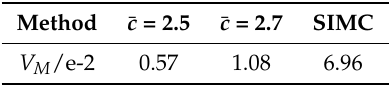
Table 7. Example 3. The table shows the comparison of the settings for Algorithm 1 and SIMC using the main performance objective V M (Equation (42)).